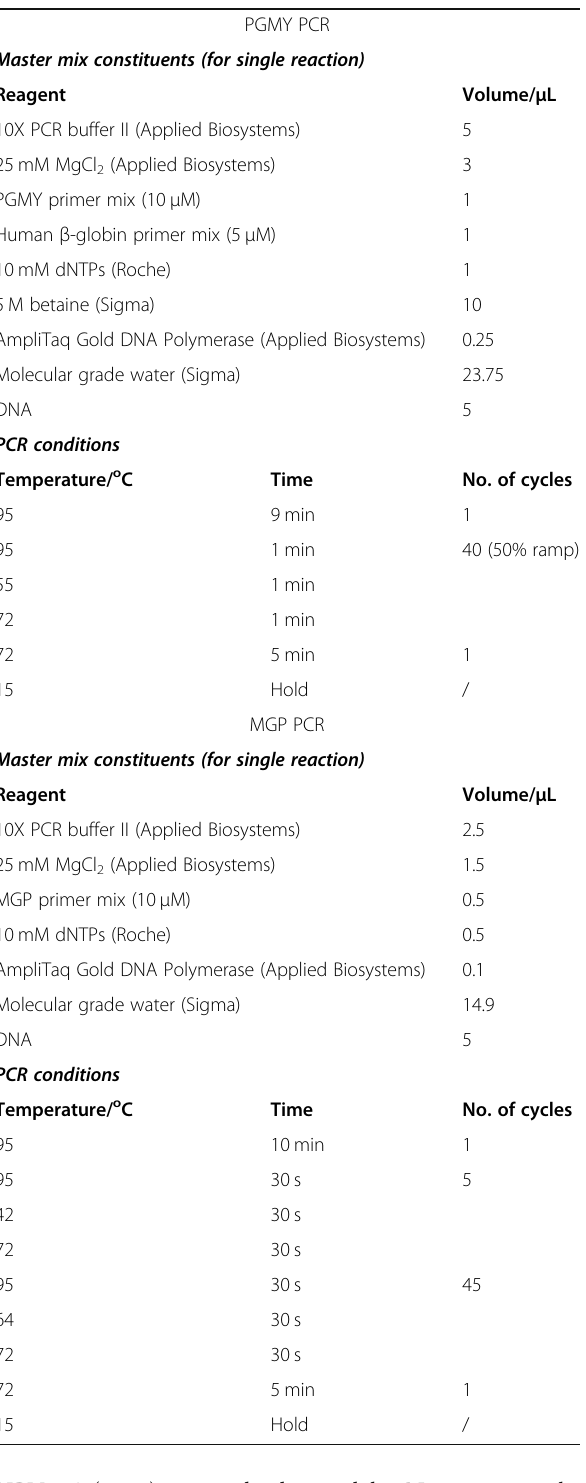
Table 7 reveals the percentage of identity of Nanopore consensus sequences to HPV reference genomes. In